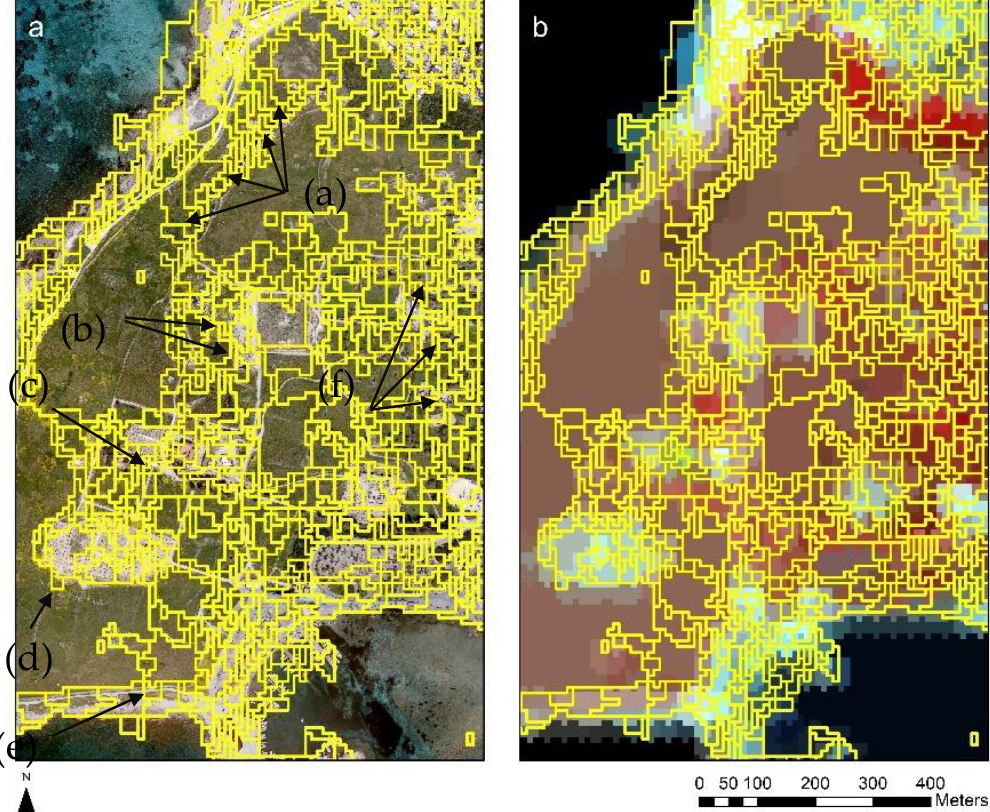
Figure 9. ( a ) Segmentation of the fused Landsat 8, after the application of the Gram–Schmidt method (indicated with yellow polygons) over the high-resolution aerial photograph of the archaeological site of “Nea Paphos”; ( b ) segmentation of the original Landsat 30 m pixel resolution. For the details of areas (a) to (f) refer to the